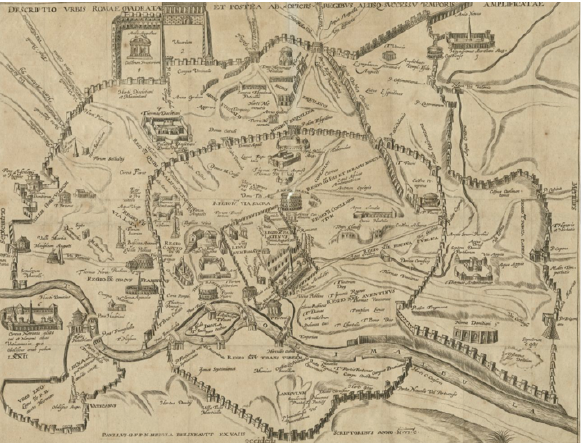
Figure 7. Map of Rome of Paulus Merula e Pirro Ligorio, 1600 The representation of Giovanni Battista Falda (Figure 8) is one of the most truthful, so much so that already at the time of its publication it was considered the updated version of Tempesta's drawings. The attention to detail and the scientific nature of the representation leads it to be one of the most detailed maps of Ancient Rome. Specifically, regarding the area of Testaccio, it is the only map mentioned in the text to represent not only the external walls but also the inner walls of the fields. The great amount of detail of representation not only of the external walls but also the internal features are one of the common denominators with the map of the Tempesta. (Borsi, 1986) Unlike this one, however, given the temporal offset, it represents the walls in a state of abandonment, representing 5 sighting towers and what appear to be the remains of three other destroyed areas.